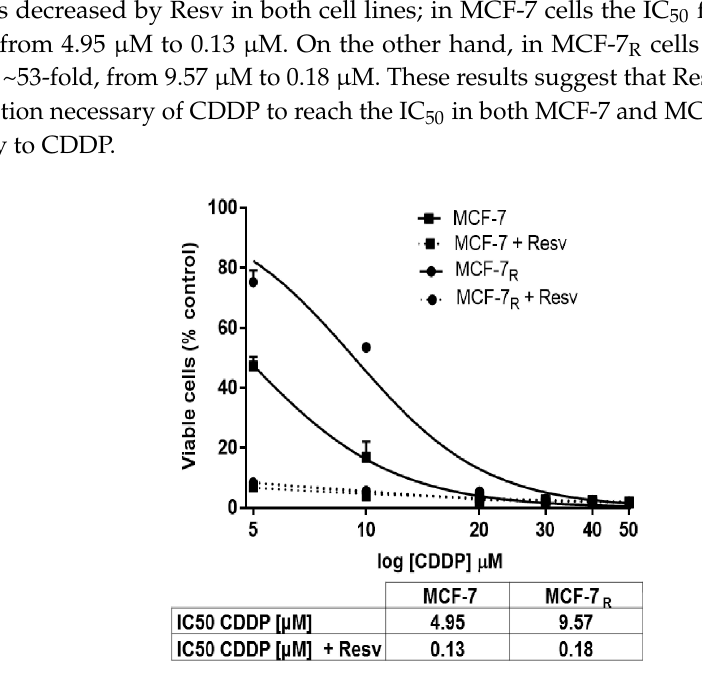
Figure 1. Resveratrol (Resv) induces sensitivity to cisplatin (CDDP) in MCF-7 R cells. MCF-7 and MCF- 7 R cells were treated with different concentrations of CDDP (5, 10, 20, 30, 40, and 50 μ M) with or without Resv (100 μ M) for 48 h. Cell viability was tested by 3-(4,5-dimethylthiazol-2-yl)-2,5- diphenyltetrazolium bromide (MTT) assay. Each data point is the mean of four independent Resv (100 µ M) for 48 h. Cell viability was tested by 3-(4,5-dimethylthiazol-2-yl)-2,5-diphenyltetrazolium experiments ± SD. The IC 50 values for CDDP were calculated and shown in the box. bromide (MTT) assay. Each data point is the mean of four independent experiments ± SD. The IC 50 values for CDDP were calculated and shown in the